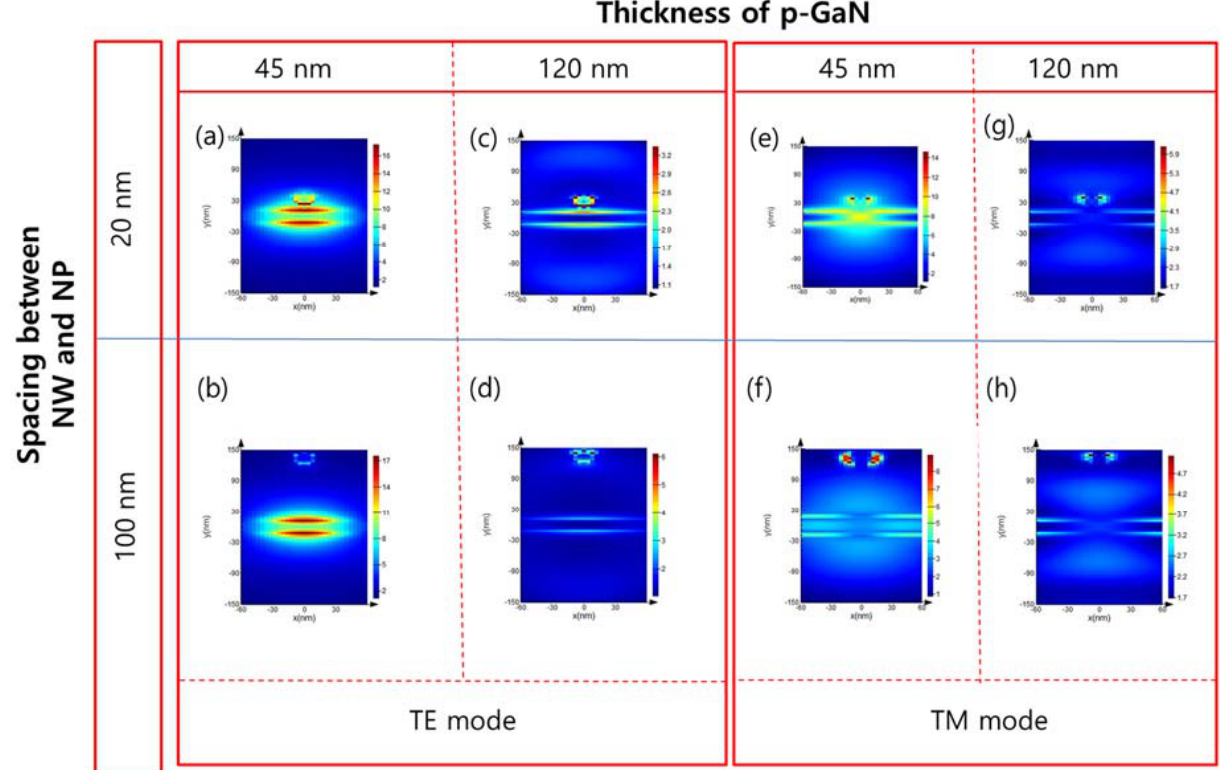
Figure 4. FDTD simulation of Ag NW/NP TCEs using sapcing between the Ag NW and Ag NP of 20 nm with ( a ) 45 nm and ( c ) 120 nm-thick p-GaN for TE mode and ( e ) 45 nm and ( g ) 120 nm-thick p-GaN for TM mode. That of of Ag NW/NP TCEs using sapcing between the Ag NW and Ag NP of 100 nm with ( b ) 45 nm and ( d ) 120 nm-thick p-GaN for TE mode and ( f ) 45 nm and ( h ) 120 nm-thick p-GaN for TM mode.